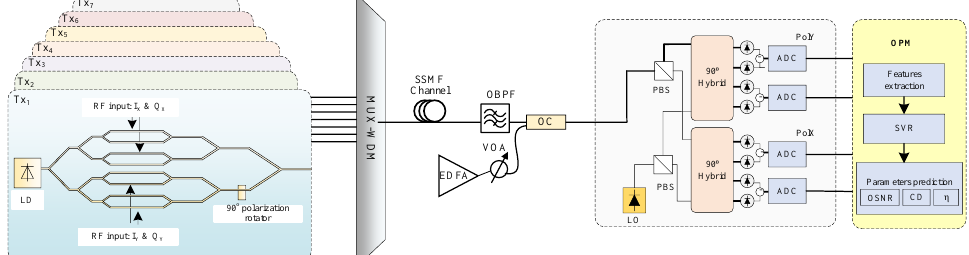
Figure 7. Simulation setup of the proposed OPM in super-channel networks. LD: laser diode, EDFA: Erbium-doped fiber amplifier, VOA: variable optical attenuator, WDM: wavelength division multi- plexing, MUX: multiplexer, OBPF: optical band pass filter, PBS: polarization beam splitter, OC: optical coupler, ADC: analog to digital convertor, LO: local oscillator, SVR: support vector regressor, η : interfer- ence ratio, OPM: optical performance